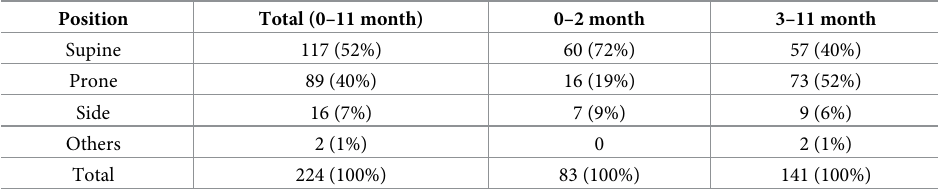
Table 3. Sleep position at the